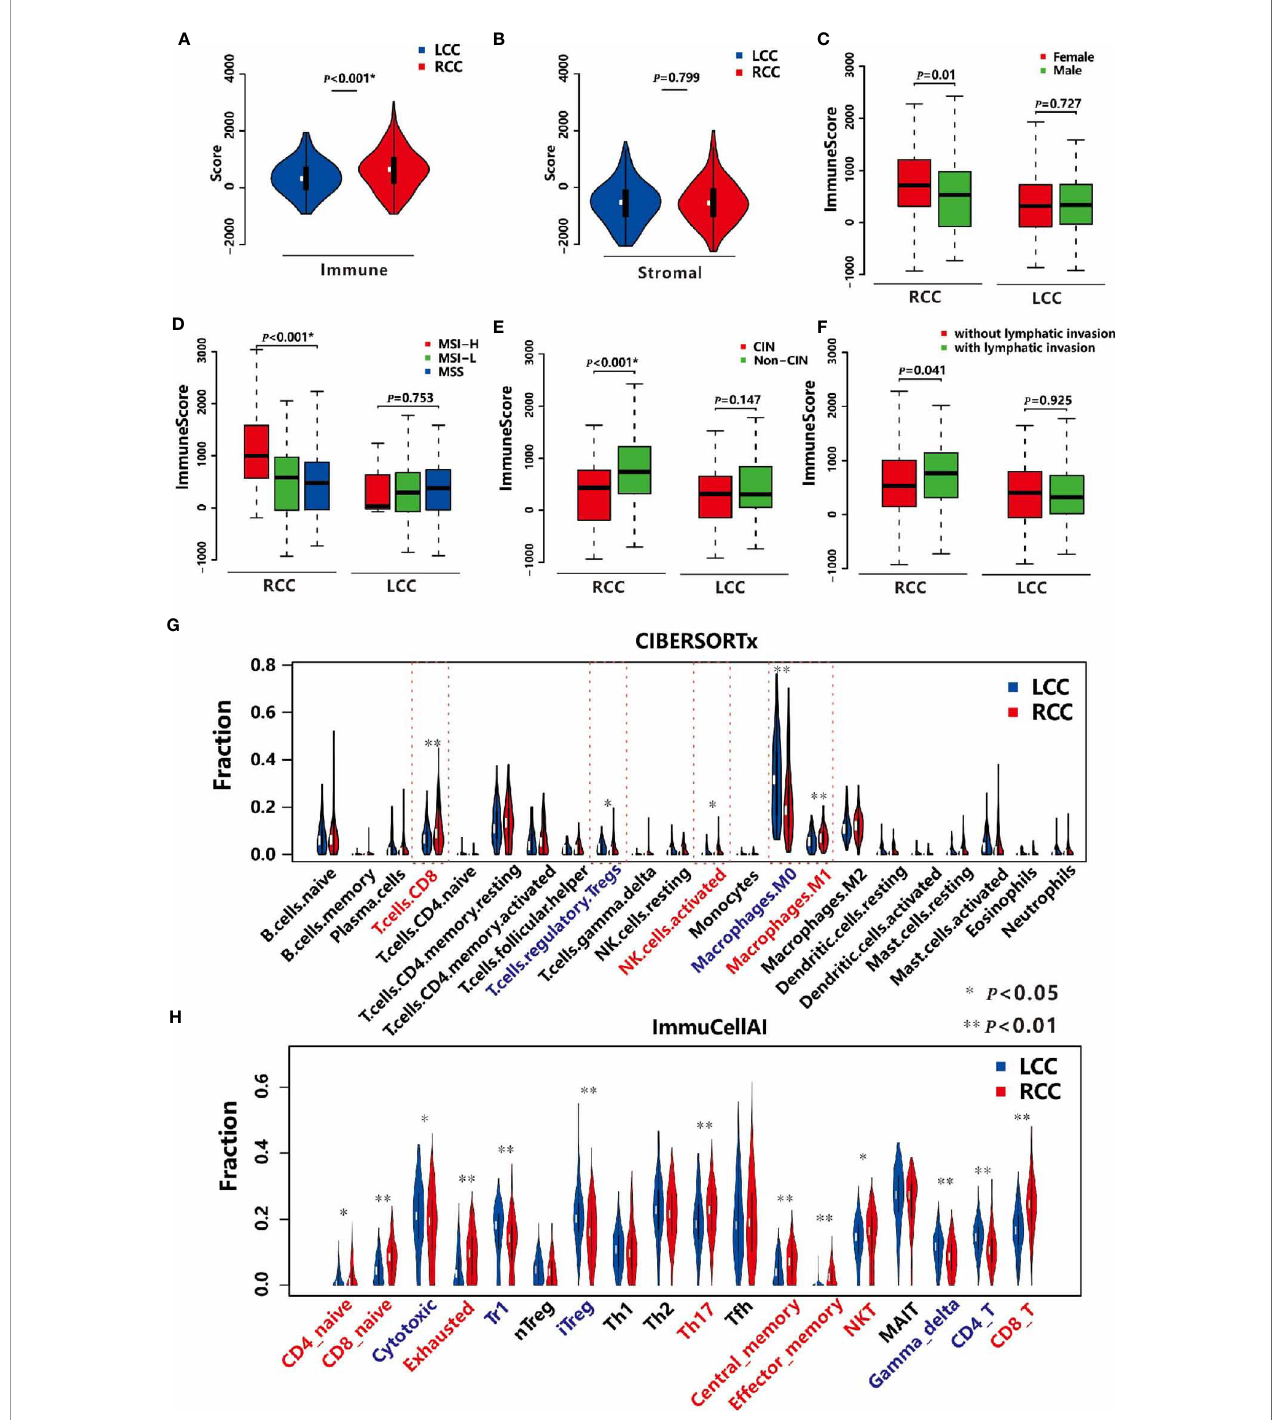
FIGURE 1 | TIME in LCC and RCC. (A) Comparison of the immune scores between LCC and RCC. (B) Comparison of the stromal scores between LCC and RCC. (C) Comparison of the immune scores between female and male patients in RCC and LCC respectively. (D) Comparison of immune scores among patients with MSI-H, MSI-L, and MSS in RCC and LCC respectively. (E) Comparison of immune scores between patients with CIN and non-CIN in RCC and LCC respectively. (F) Comparison of immune scores between patients with and without lymphatic invasion in RCC and LCC respectively. (G) Comparison of 22 immune cells based on CIBERSORTx software between RCC and LCC. (H) Comparison of 18 T cells based on ImmuCellAI software between LCC and